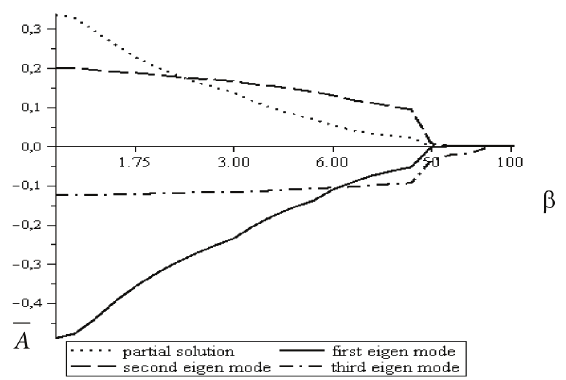
Fig. 1. Amplitude of the sphere’s relative speed of external surface 0 r R = versus the anisotropy parameter / the three modes of natural vibrations and forced vibration with the relative frequency 1 / 4 v = l at 1 0 / 0.50 R R e = = , 400 g